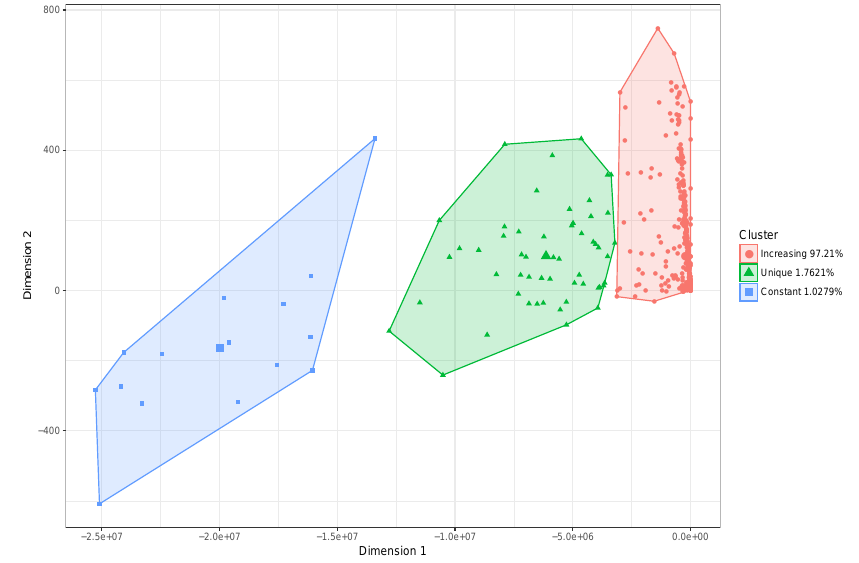
Figure 11. Segments classification through clustering for the logistic regression in the hotspot scenario.